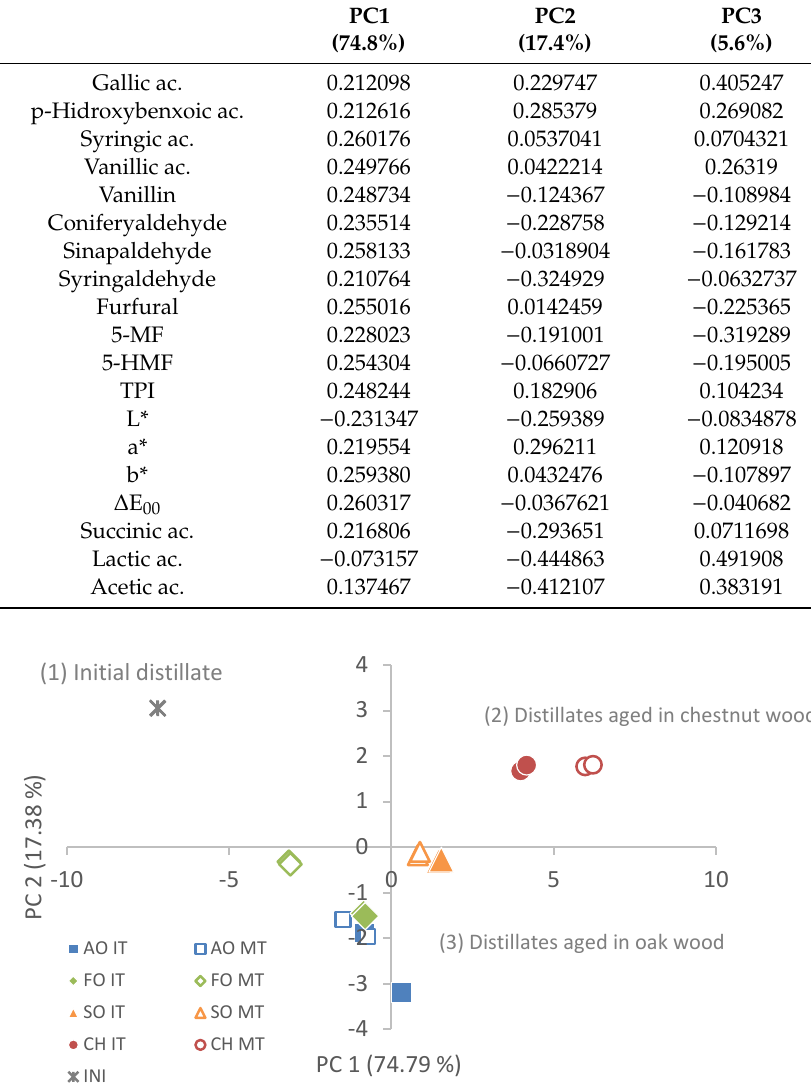
Table 5. Weights of the variables for each Principal Component of PCA.